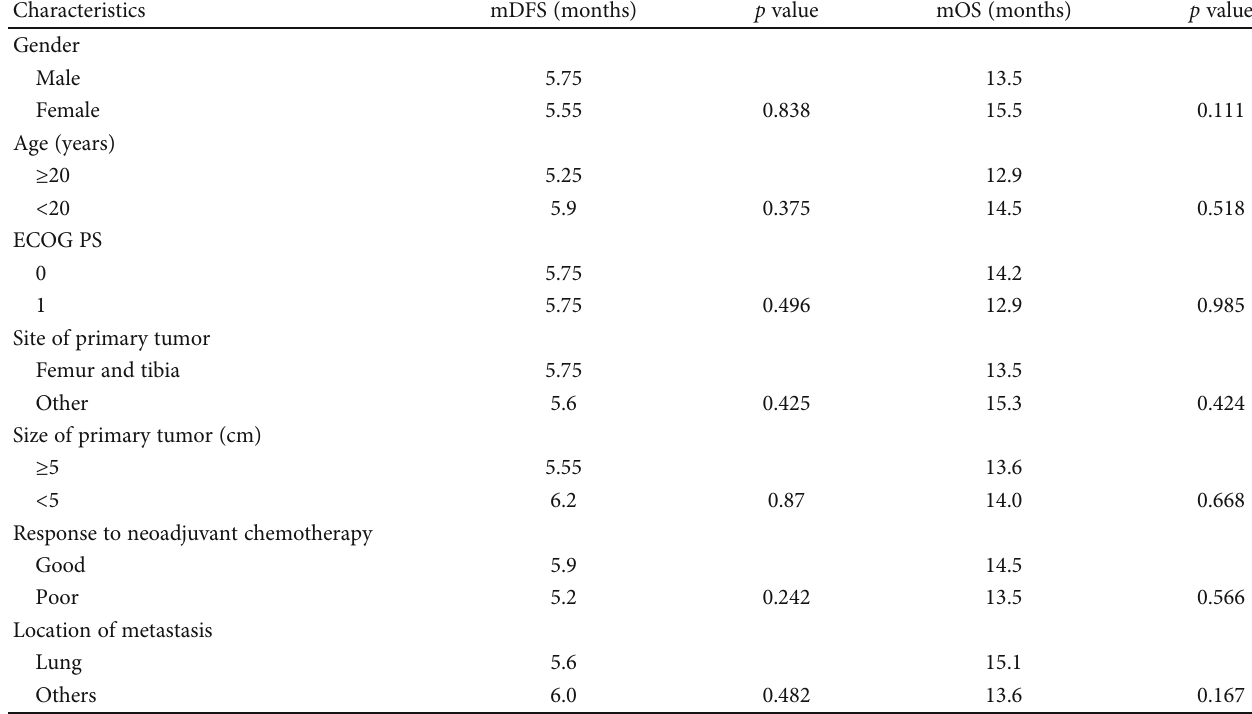
Table 4: Univariate analysis of factors related to mDFS and mOS of patients in this study ( N = 60 ).